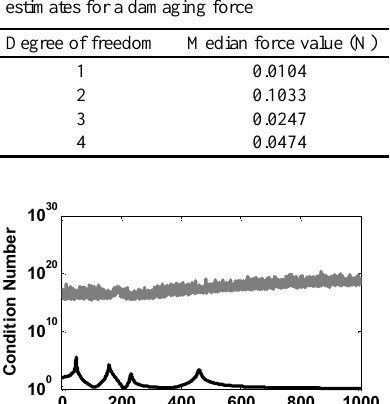
Fig. 6. Condition number for the FRF matrices used in the force estimate calculations for DOF1 and DOF2 (——) and DOF3 and DOF4 (– – –).